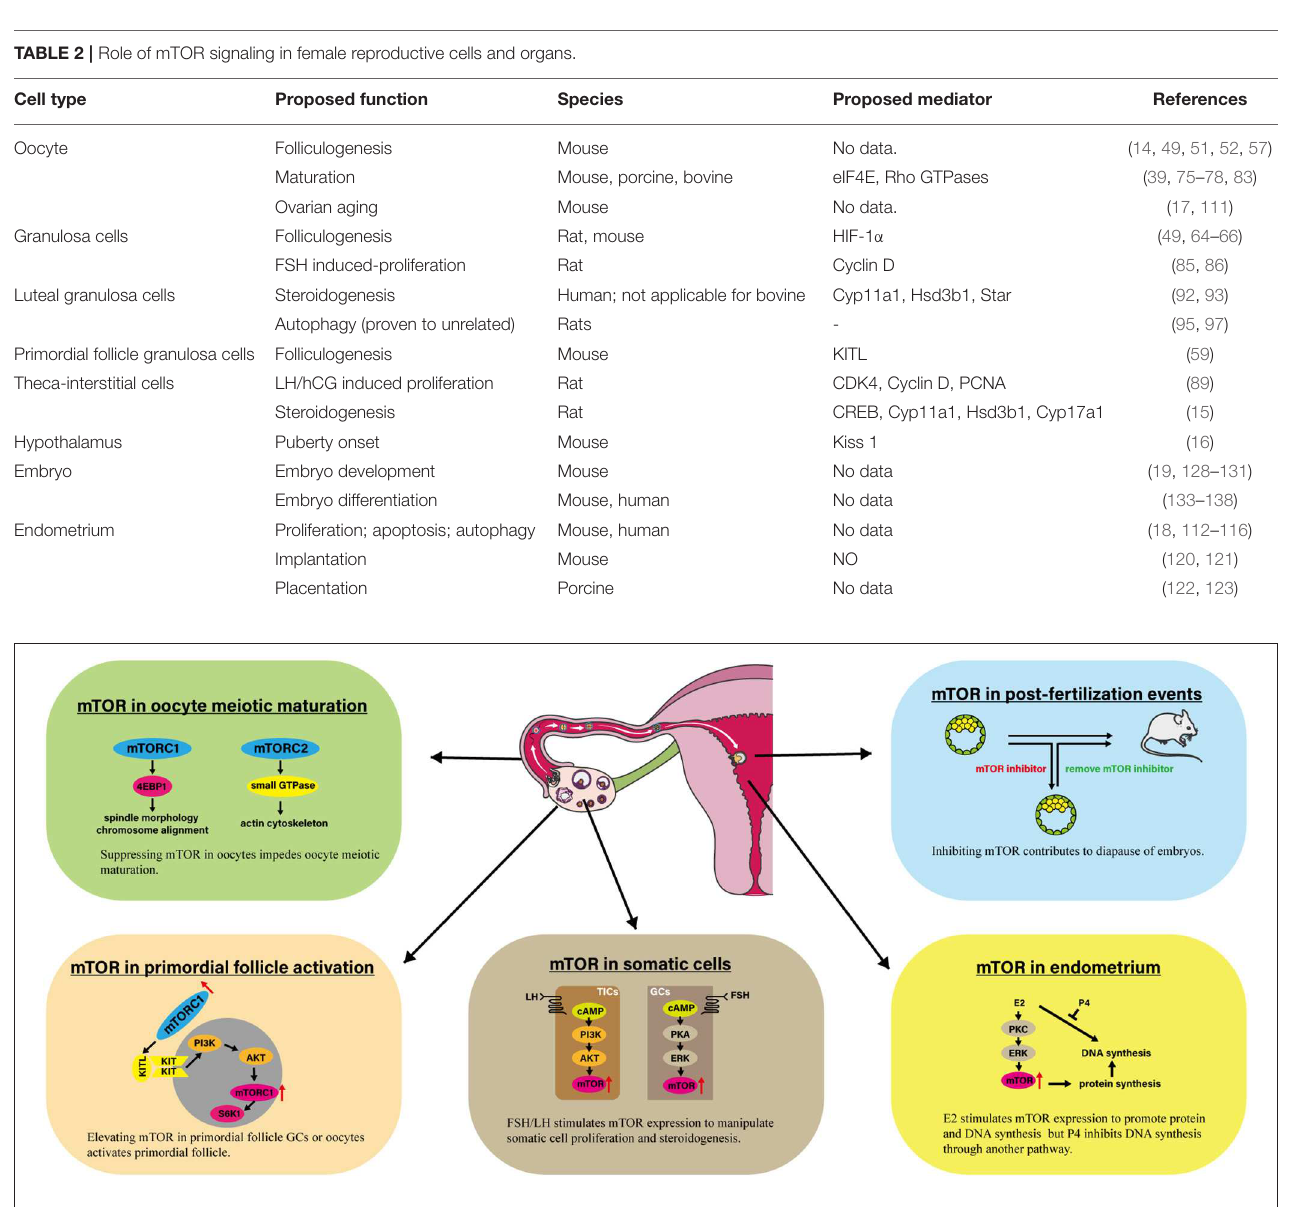
FIGURE 1 | Involvement of mTOR in several processes linked to female reproduction. The impressive events are presented involving mTOR in primordial follicle activation, oocyte meiotic maturation, somatic cells, endometrium, and post-fertilization events. AKT, Protein kinase B; E2, Estradiol-17 β ; 4EBP1, eIF4E Binding Protein 1; ERK, Extracellular signal regulated kinase; KITL, KIT ligand; mTOR, Mammalian target of rapamycin; mTORC1, mTOR complex 1; P4, Progesterone; PI3K, Phosphoinositide 3-kinase; PKA, Protein kinase A; PKC, Protein kinase C; S6K1, p70S6 Kinase 1.